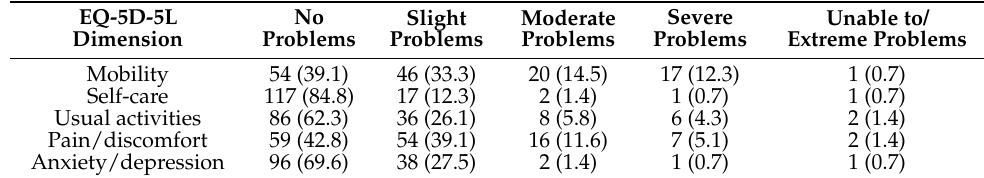
Table 3. EQ-5D-5L characteristics of participants ( n = 138).